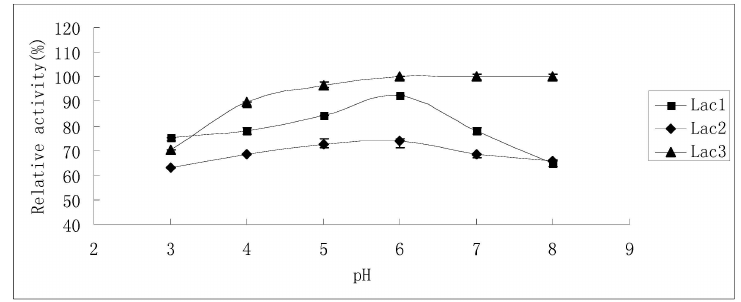
Figure 6. Stability of purified P. nebrodensis laccases after exposure to different pH values for 24 h. Measurements were carried out in triplicate (standard deviations for all data points <